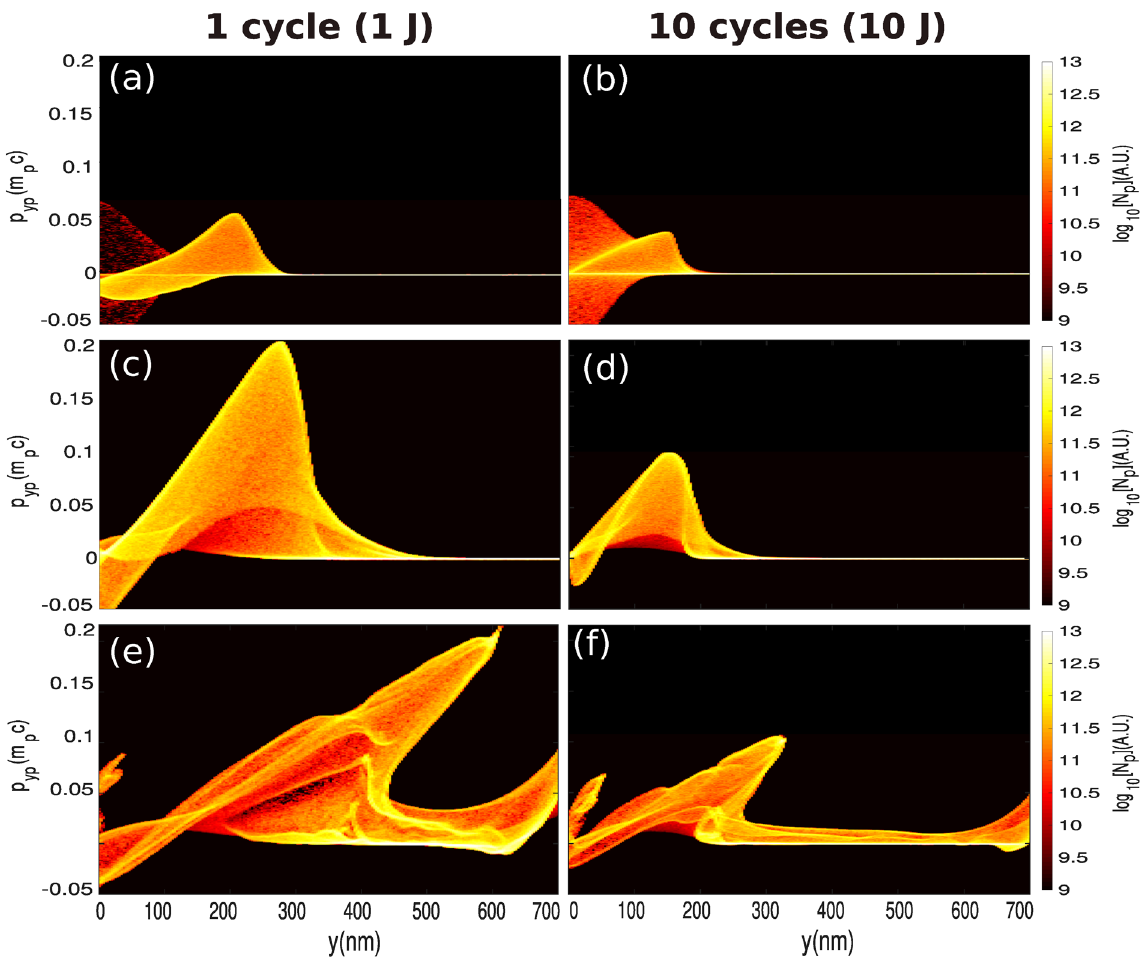
50 T 90 T 250 T L , ( c , d ) t = L and ( e , f ) t = L . ( a – c – e ) with a single- =